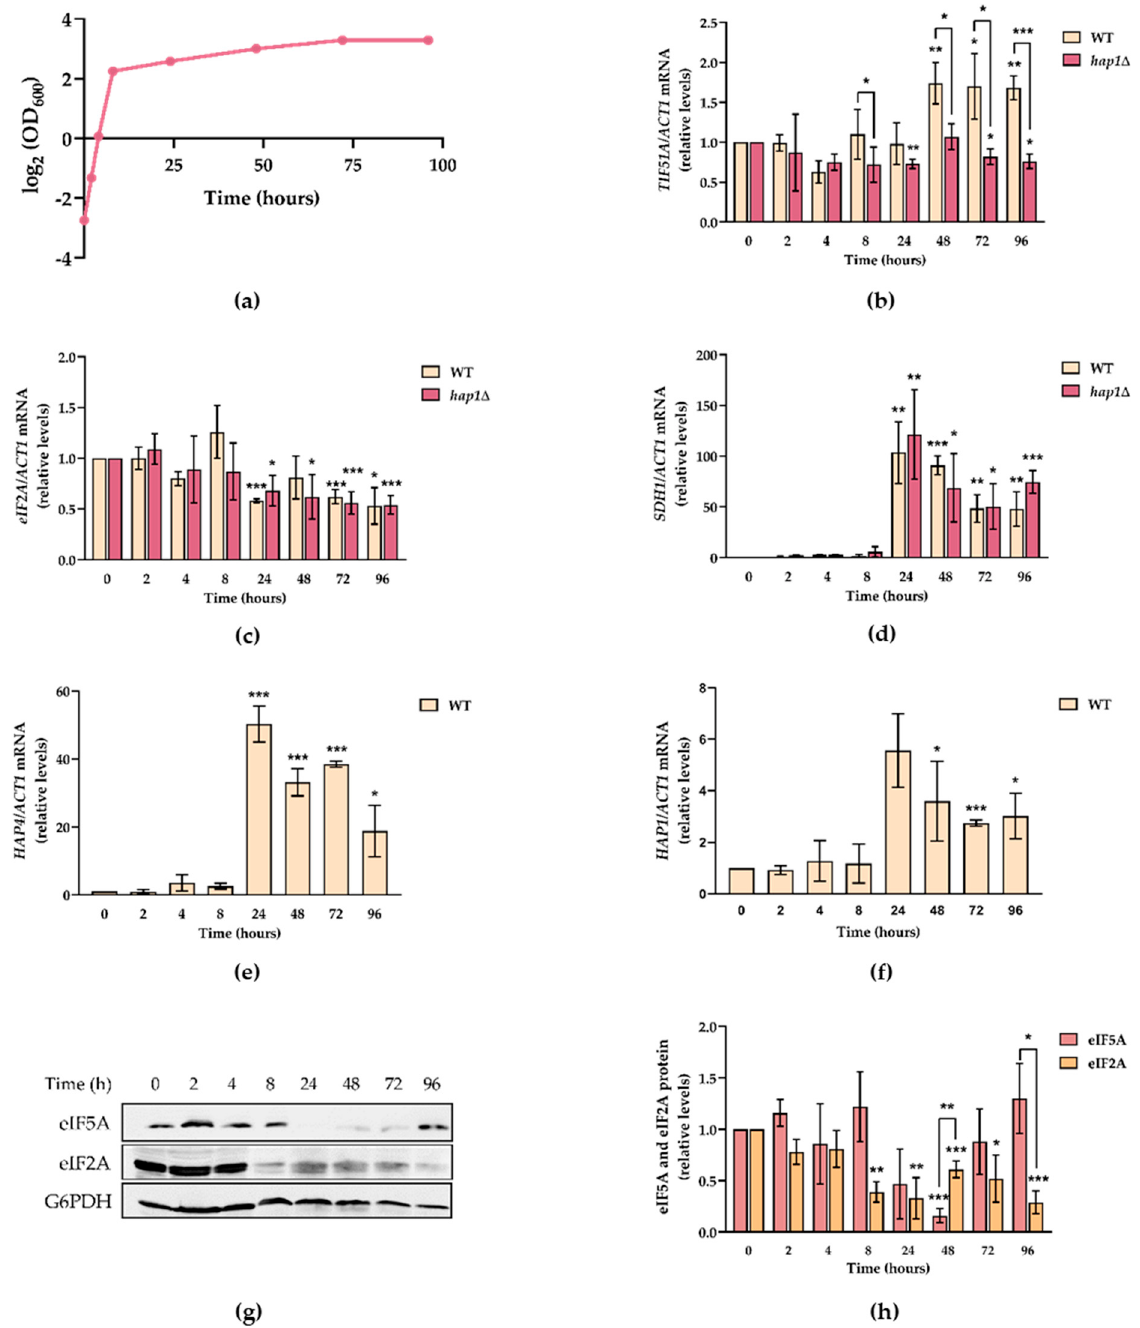
Figure 3. Tif51A expression drops during glucose exhaustion but recovers in a Hap1-dependent manner in the post-diauxic phase. ( a ) The WT and hap1 ∆ cells were grown in YPD medium for 96 h and samples were collected at the indicated time points. ( b – f ). Relative TIF51A ( b ), eIF2A ( c ), SDH1 ( d ), HAP4 ( e ) and HAP1 ( f ) mRNA levels were determined. ( g , h ). A representative Western blotting experiment ( g ) and quantification analysis ( h ) of the eIF5A and eIF2A protein levels in the WT cells at the indicated time points. G6PDH protein levels were used as loading controls. The results are shown as the means ± SD of three independent experiments and are expressed in relation to the value at time 0. Statistical significance was measured by a Student’s t -test in relation to time 0. * p < 0.05, ** p < 0.01, *** p < 0.001.